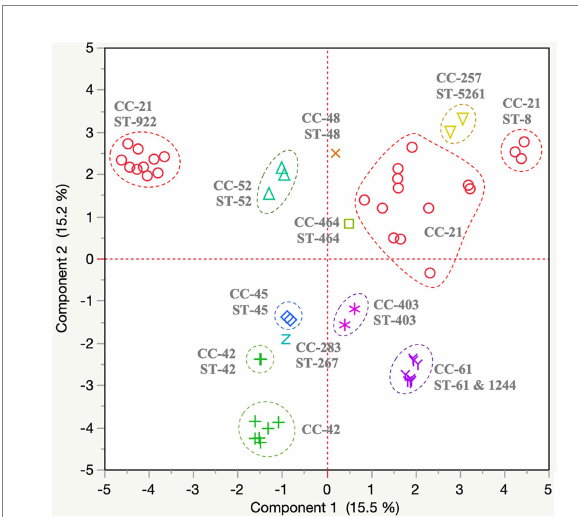
FIGURE 3 Variable genome distribution of Campylobacter jejuni ( n = 56) isolated from dairy manure in small specialty crops farms in Northeast Ohio between 2018 and 2020. A total of 401 protein-encoding genes were identified as part of the C. jejuni variable genome and were used to create this distance matrix plot. Dotted circles indicate specific clonal complex (CC)-sequence type (ST) clusters. The color of each dot within the plot represents a different CC. The principal component plot is defined by component 1 and 2, which explains 15.5% and 15.2%, respectively of variations based on the variable- genome ( n = 401 protein encoding genes) of the 56 C. jejuni